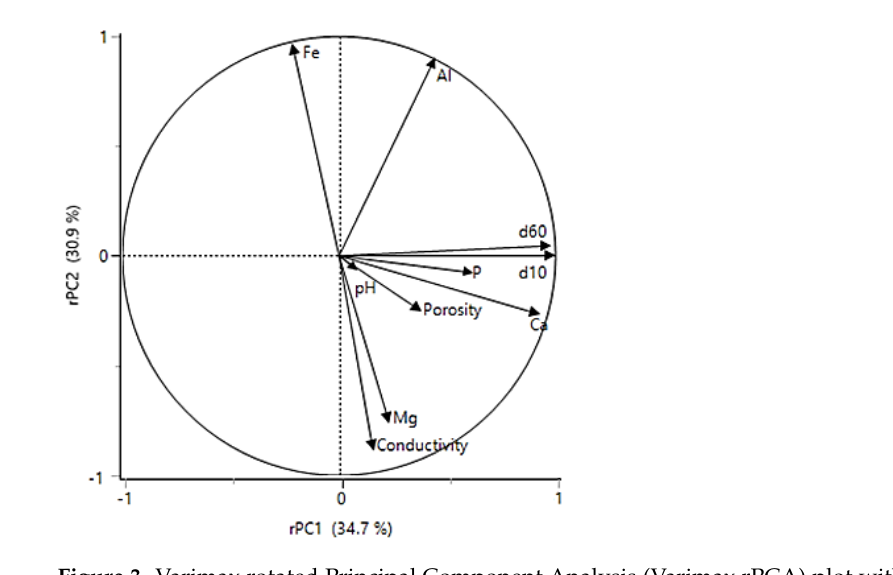
Figure 3. Varimax rotated Principal Component Analysis (Varimax rPCA) plot with rPC1 (34.7%) and rPC2 (30.9%) performed for the following parameters of the non-coated materials: conductivity, pH, bulk porosity, particle size distribution ( d 10 and d 60 ), and mineral concentration of Al, P, Fe, Ca, and Mg.